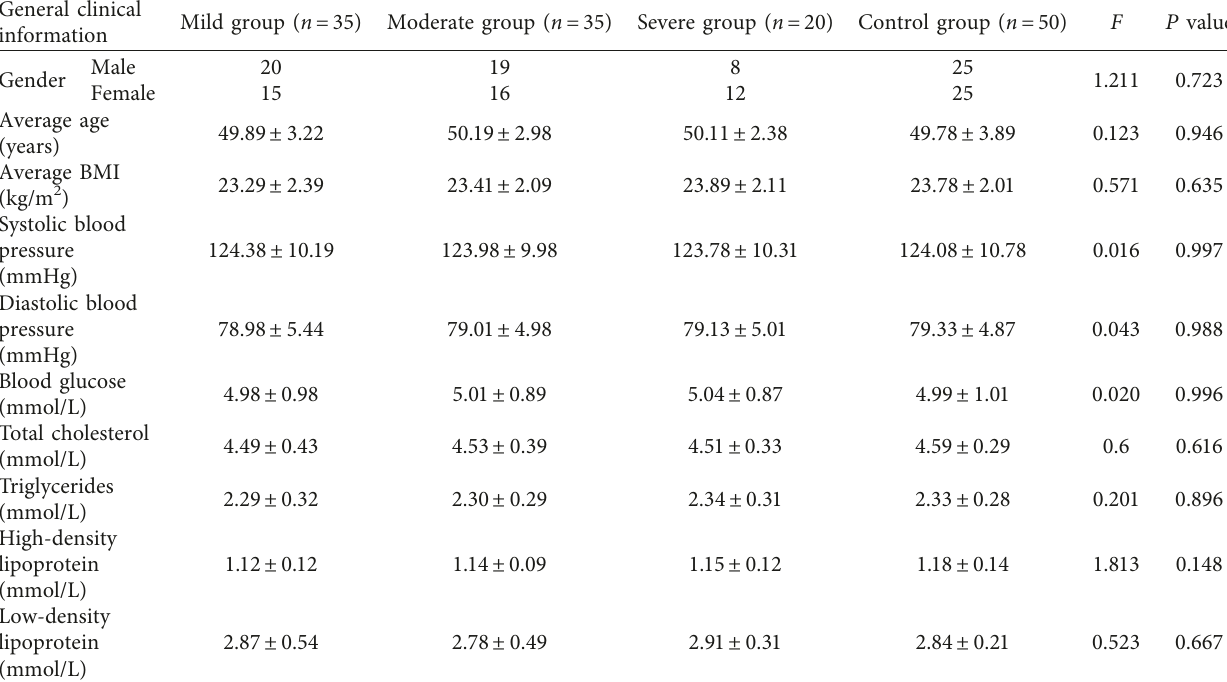
Table 1: Comparison of baseline information of patients in different groups ( x ± s )/( n (%)). General clinical